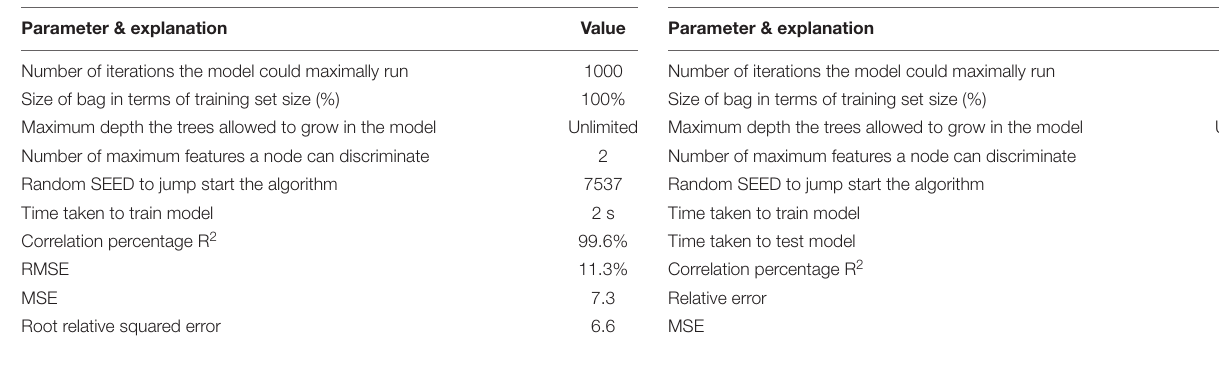
TABLE 3 | Parameters and results for Random Forest prediction model on testing data